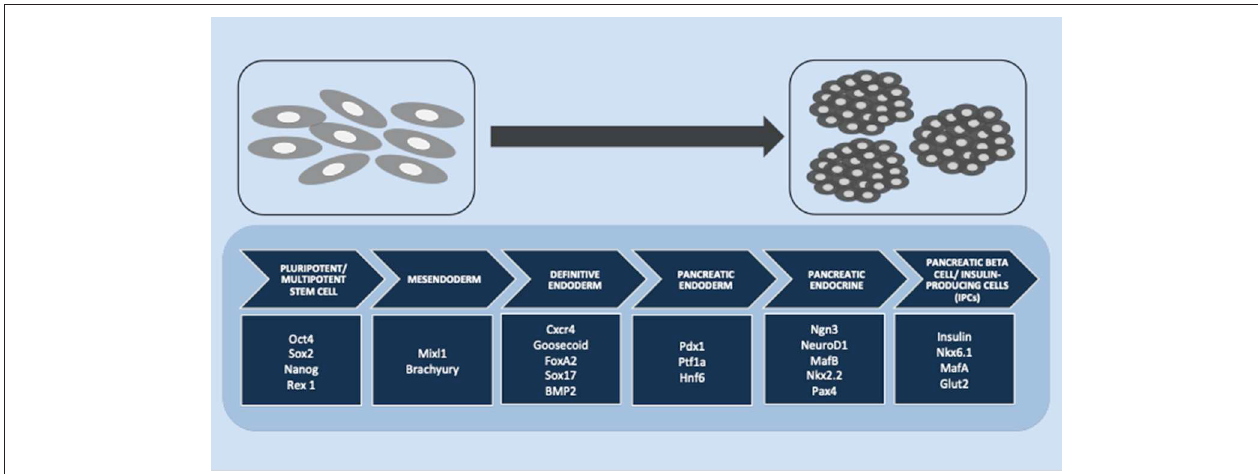
FIGURE 1 | Stages of insulin-producing cell (IPC) differentiation. Multiple stages of IPC differentiation from pluripotent/multipotent stem cells and the role of transcription factors involved in each stage, starting from mesendoderm and definitive endoderm induction, followed by pancreatic endoderm and pancreatic endocrine differentiation, and finally, the final stage of pancreatic beta cells or IPC induction.